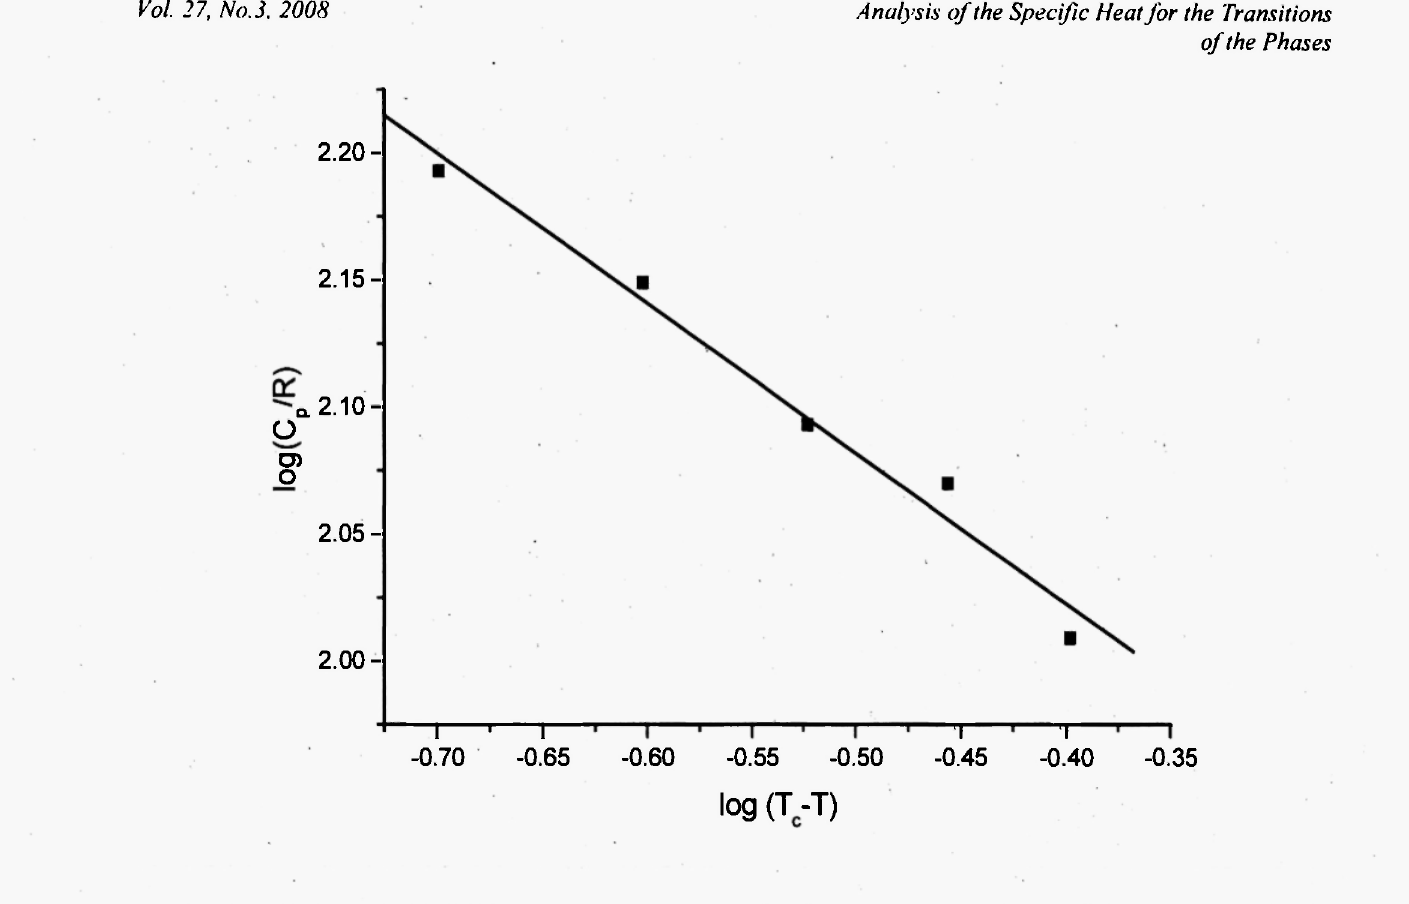
Fig. 3: Specific heat of TMATC-Cu in a log-log scale as a function of temperature for the III -VI phase transition in the temperature interval of 264.6 Κ < Τ < 265 Κ (T c =265 Κ) according to a power-law relation (Eq.l). R denotes the gas